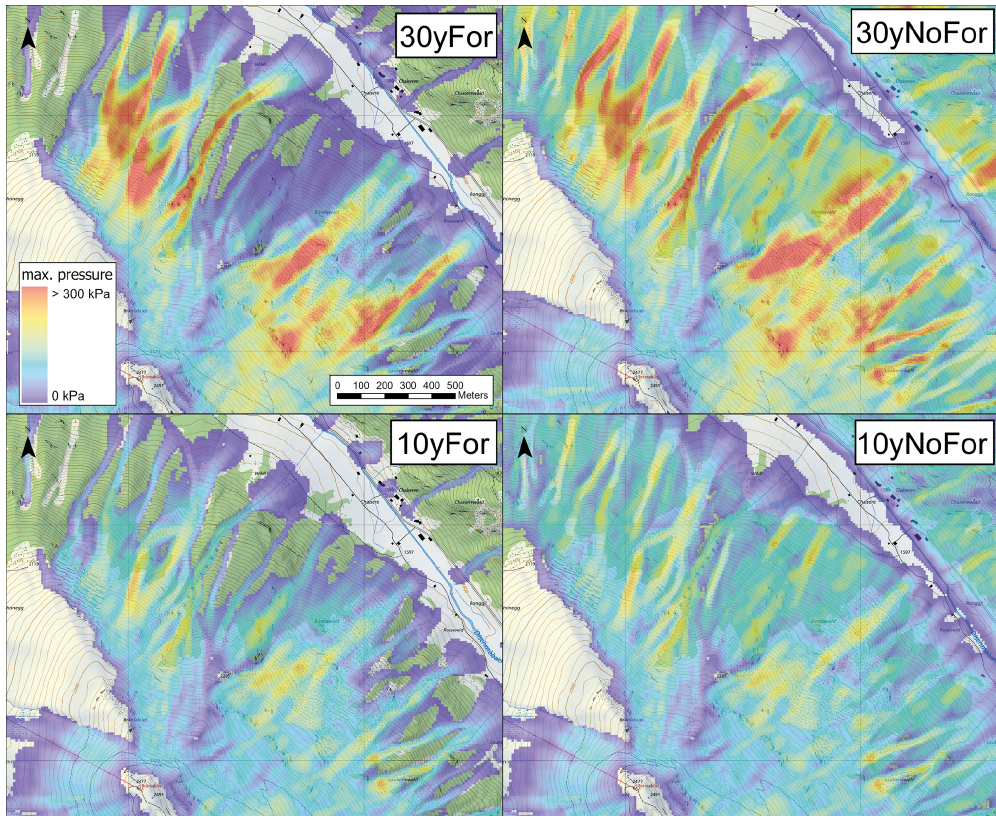
Figure 9. Maximum pressure of the simulation results for the two frequent scenarios for the subsection Duchli. The corresponding PRAs are depicted Fig. 6 (map source: Swiss Federal Office of